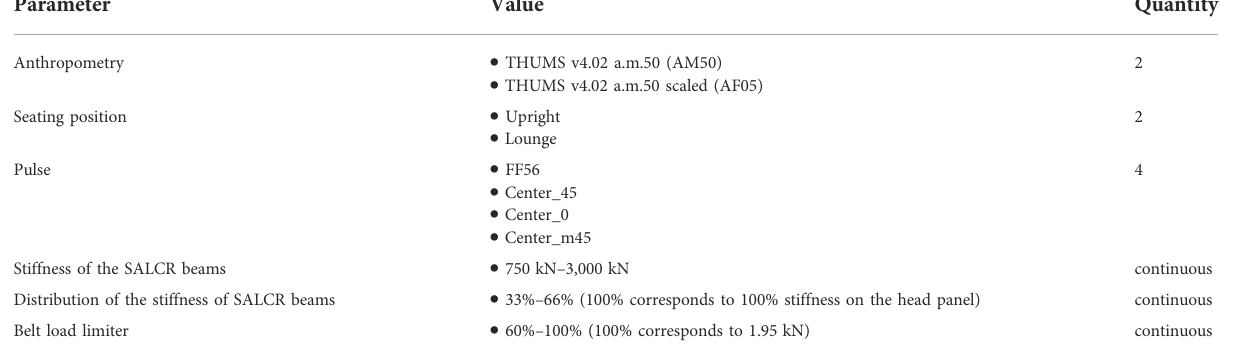
TABLE 2 Parameters to be varied with corresponding values and